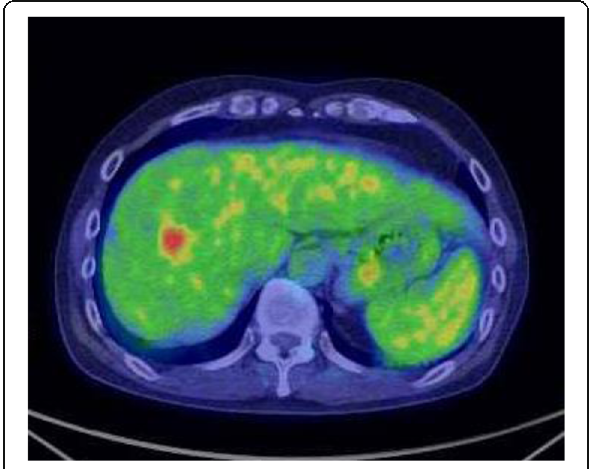
Fig. 1 Positron emission tomography-computed tomography after six courses of adjuvant chemotherapy. Imaging showed abnormal accumulation (maximum standardized uptake value of 5.8) in segment